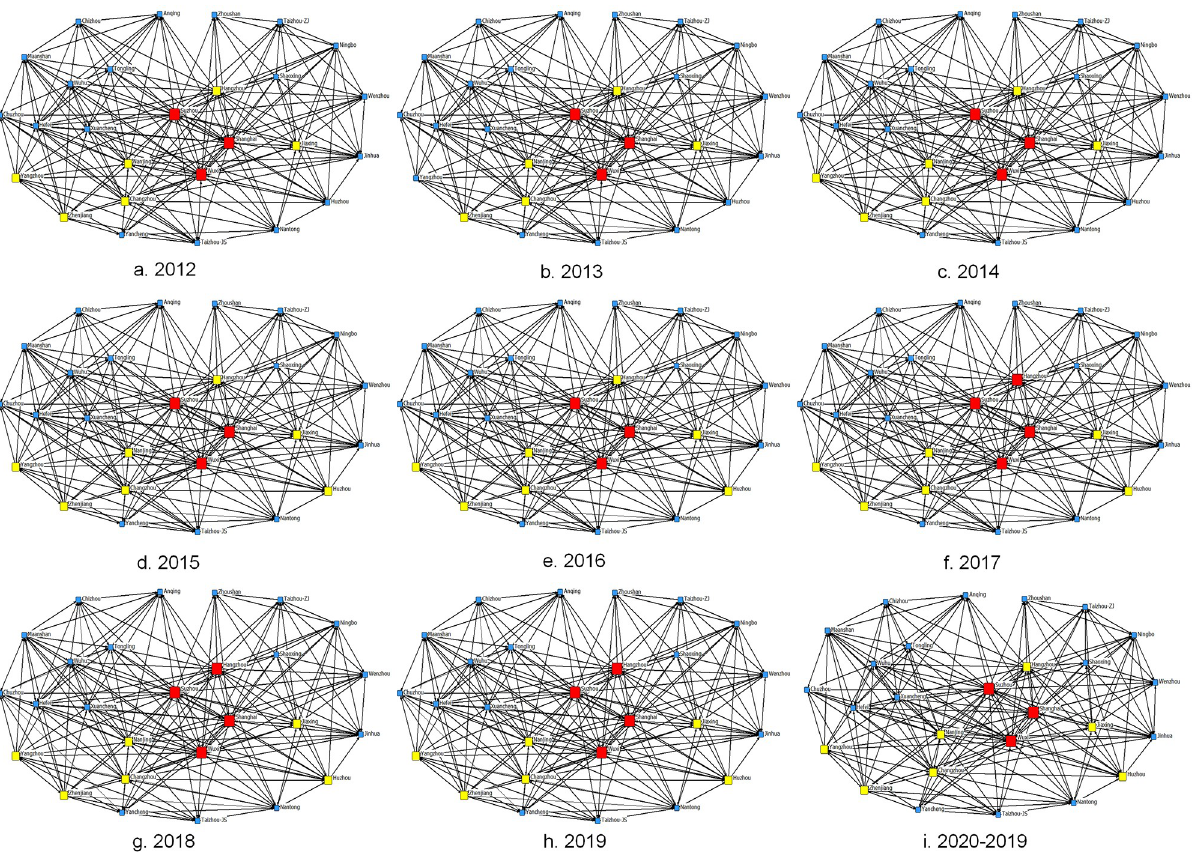
Fig 1. Spatio-temporal network of air pollution in the YRDUA. Since the number of outgoing relationships in each city ranges from 0 to 30, cities with more than 20 outgoing relationships are marked in red, those with between 10 and 20 are marked in yellow, and the others are marked in blue.